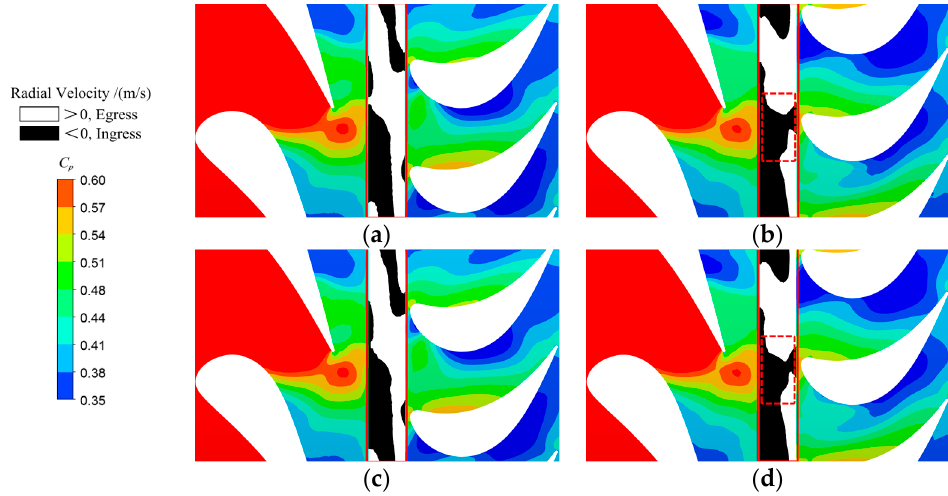
Figure 11. Radial velocity contour distributions at the clearance outlet and static pressure coefficient distributions at the endwall (Seal-A and IF = 0.6%). ( a ) (74 + 1/4) T ; ( b ) (74 + 1/2) T ; ( c ) (74 + 3/4) T ; ( d ) (74 + 1) T .